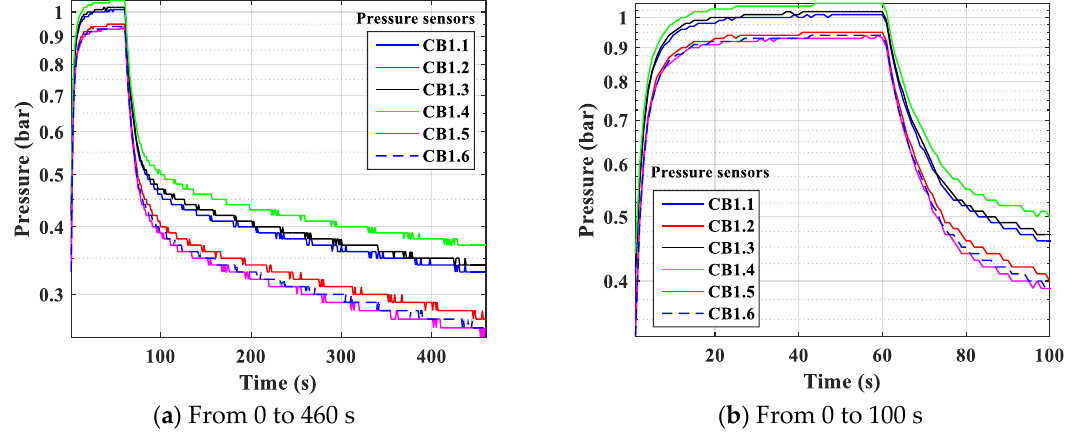
Figure 13. Pressure over time and heigh of a single fixed bed (see Figure 2).